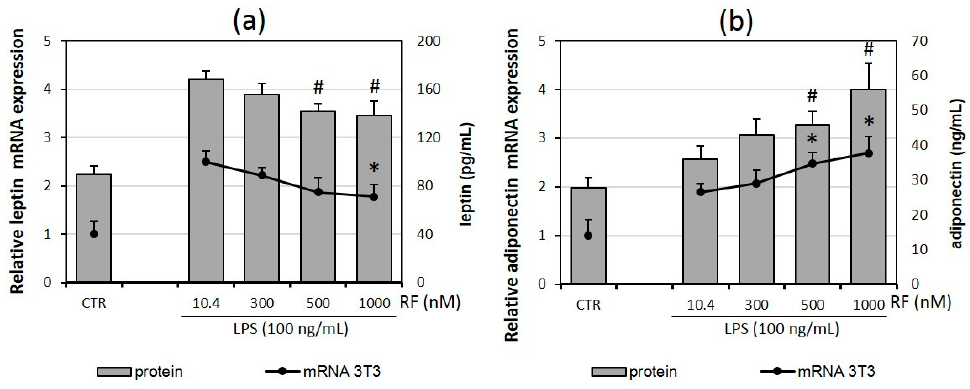
Figure 2. Effects of various riboflavin concentrations (10.4; 300; 500; 1000 nM) on LPS-induced adipokines: